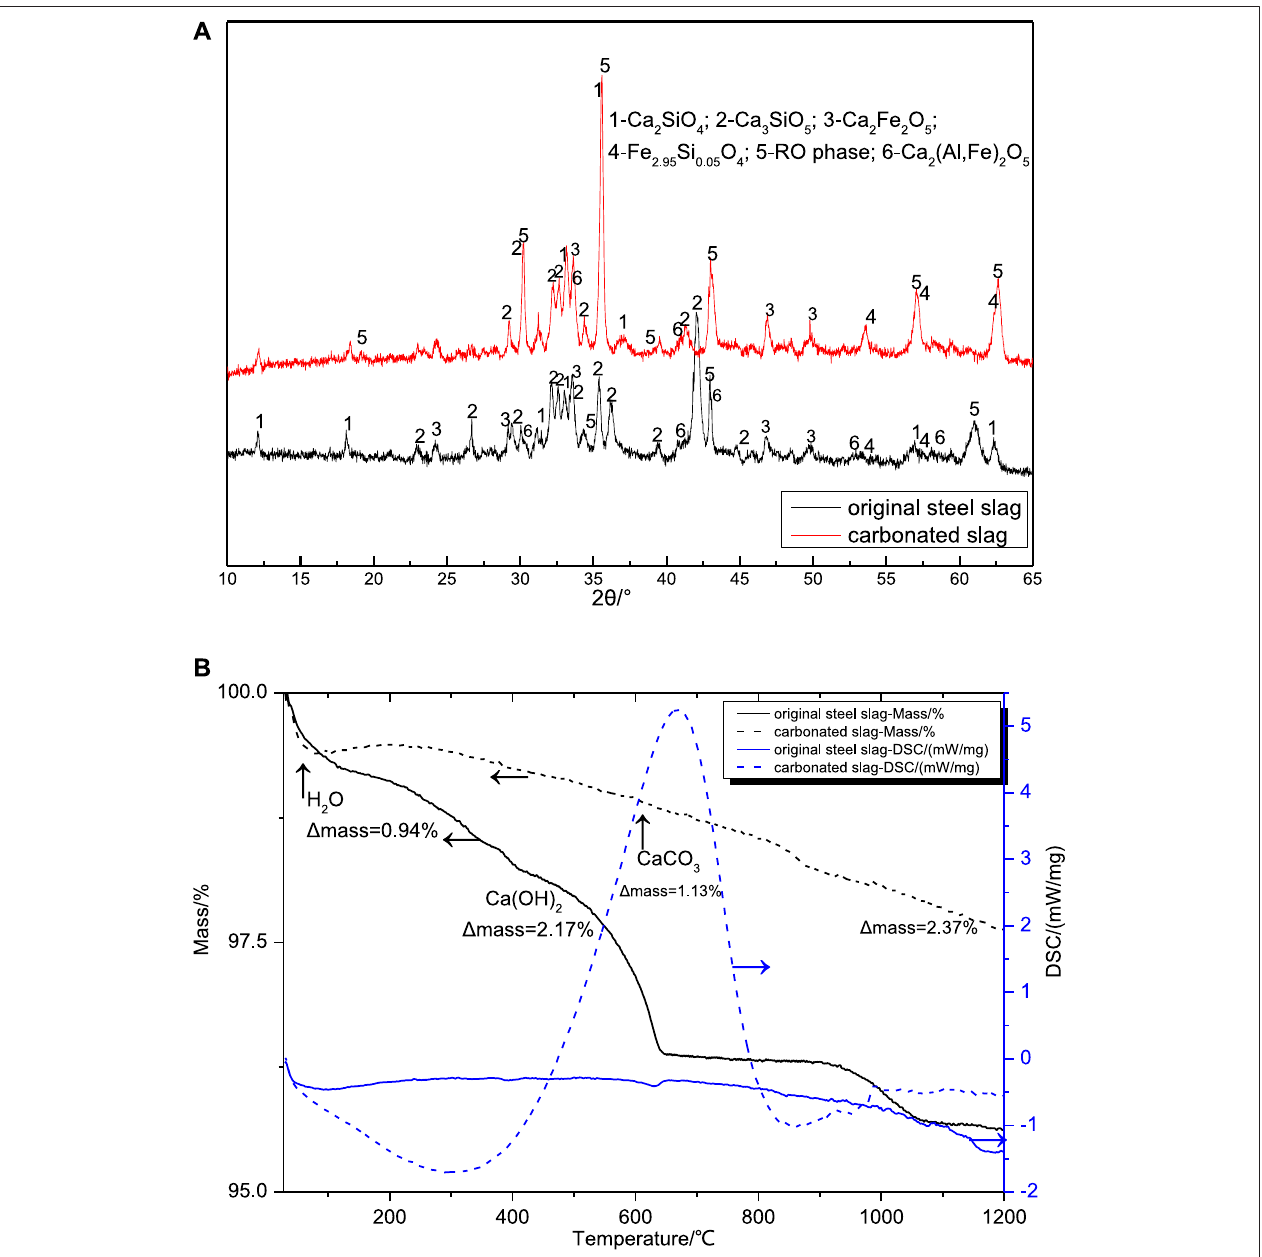
FIGURE2| XRD (A) andTG-DSC (B) analysisoforiginalEAFsteelslagandcarbonatedEAFslag.(1 – 6of Figure2A denotelarnite,calciumsilicate,srebrodolskite, iron silicon oxide, RO phase, and brownmillerite, respectively.).